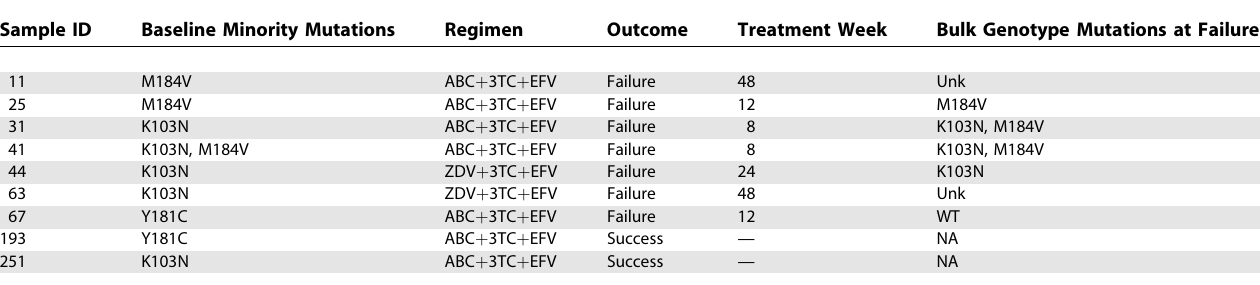
Table 5. Baseline Samples with Detectable Minority Mutations and Treatment Outcomes for Persons Who Participated in the NNRTI- Based Treatment Studies (Case-Control Group) Sample